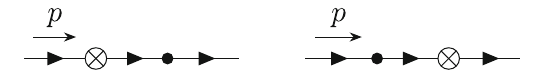
Fig. 4 The two diagrams, incorporating both f (dot) and δ f (circled cross) vertices, that have the correct structure to cancel the Lorentz- violating divergence in (cid:16) f